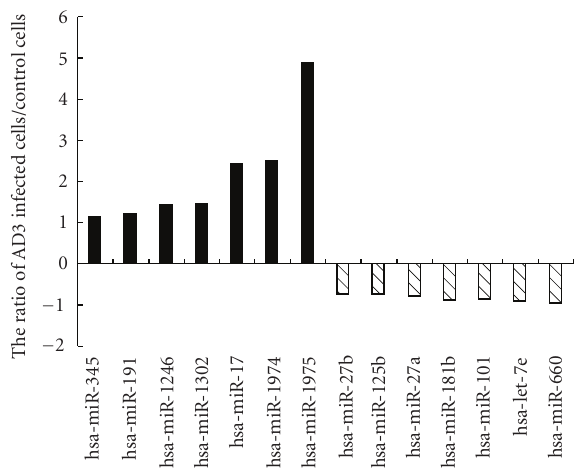
Figure 3: Quantitation of miRNA expression levels in the AD3 infected Hep2 cells and controls. Y values are the ratio of two groups of miRNAs calculated by using the equation 2 − ΔΔ CT . The black column is for upregulated miRNAs, and the gray for downregulated miRNAs.